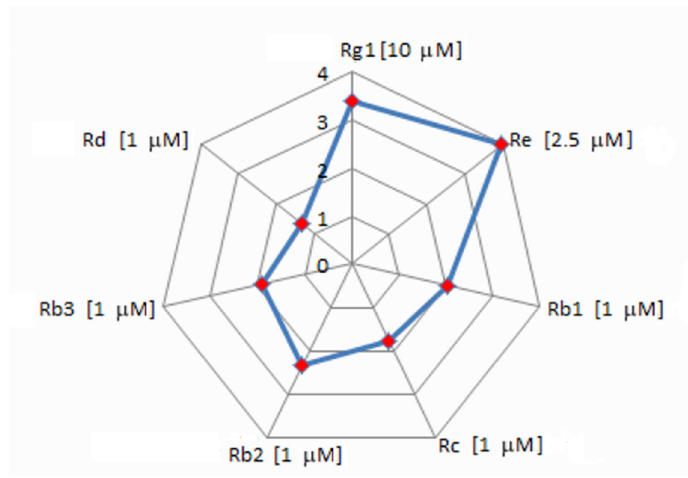
Figure 4. The maximum increase of ginsenosides in relation to untreated samples, after t -A elicitation.